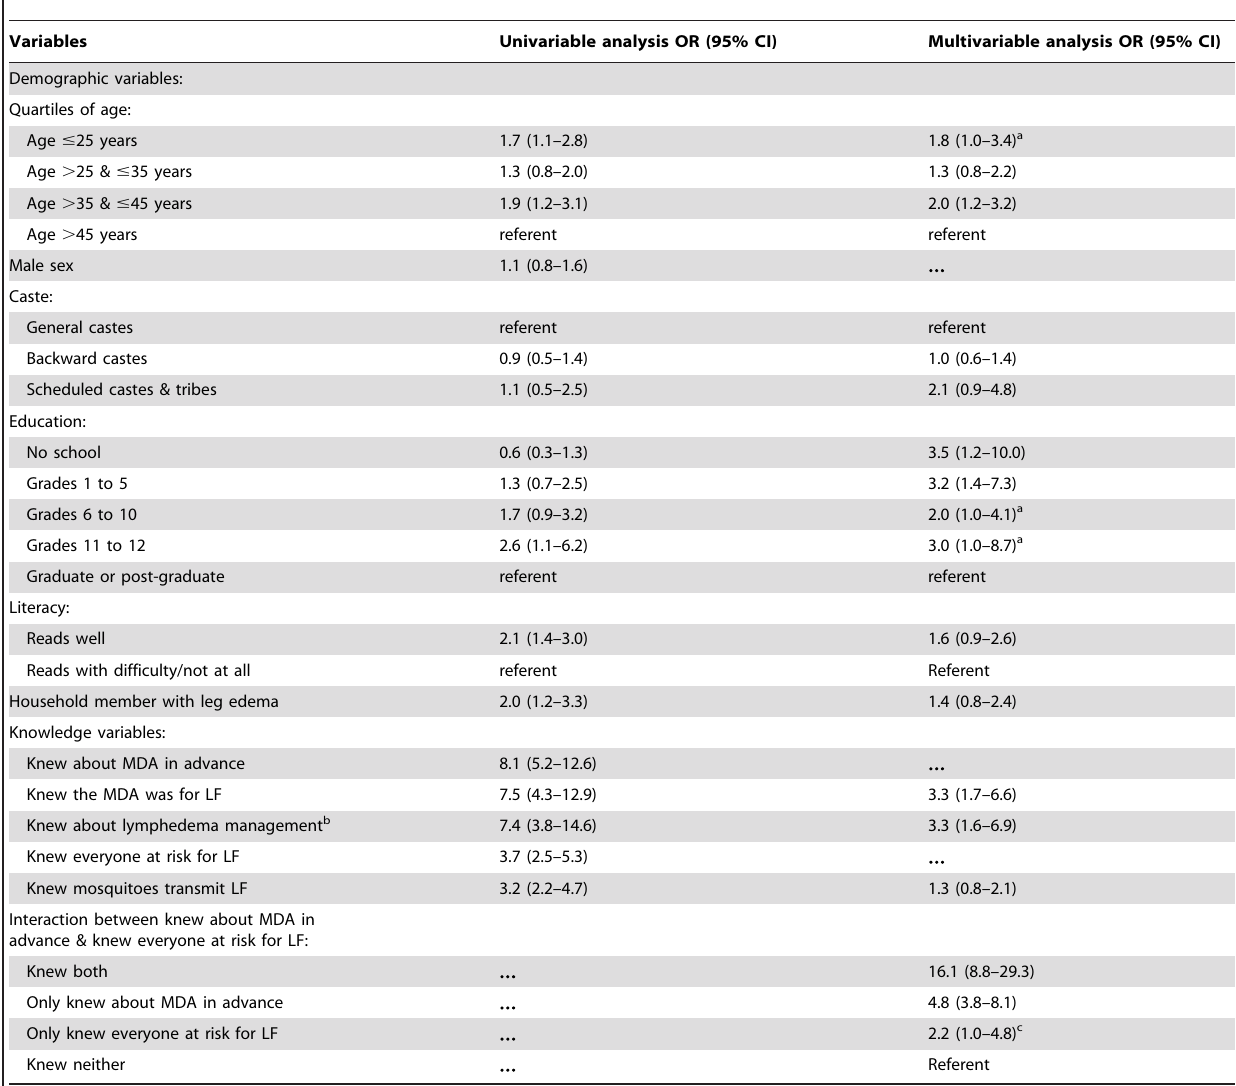
Table 4. Univariable & multivariable analyses of predictors of adherence to a DEC regimen among KAP survey participants from the 2008 MDA, Khurda District, Orissa